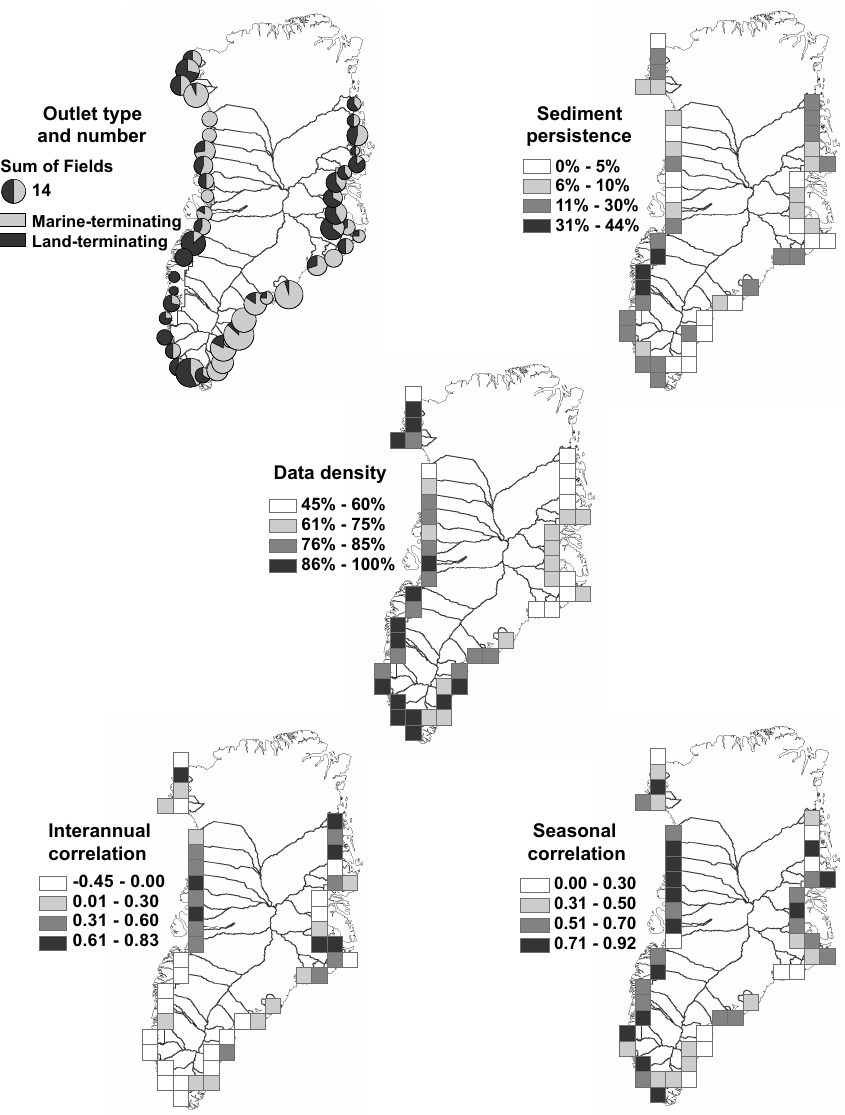
Fig. 7. Maps of parameters and analyses for each of the 47 gridcells. (a) Glacier outlet type shows the number and proportion of outlets in each gridcell that is land-terminating ( N L ) or marine-terminating ( N M ), with the size of the circle representing the total number of outlets reaching the fjord. (b) Sediment persistence ( F SSC ) shows the fraction of open water days with sediment-rich water detected. (c) Data density (DD 100km ) shows the fraction of total days with open water detected (free of ice and clouds) for the aggregated 100km data. (d) Correlation between interannual averages of PDD and SSC over 2000–2009. (e) Correlation between mean seasonal cycles of PDD and